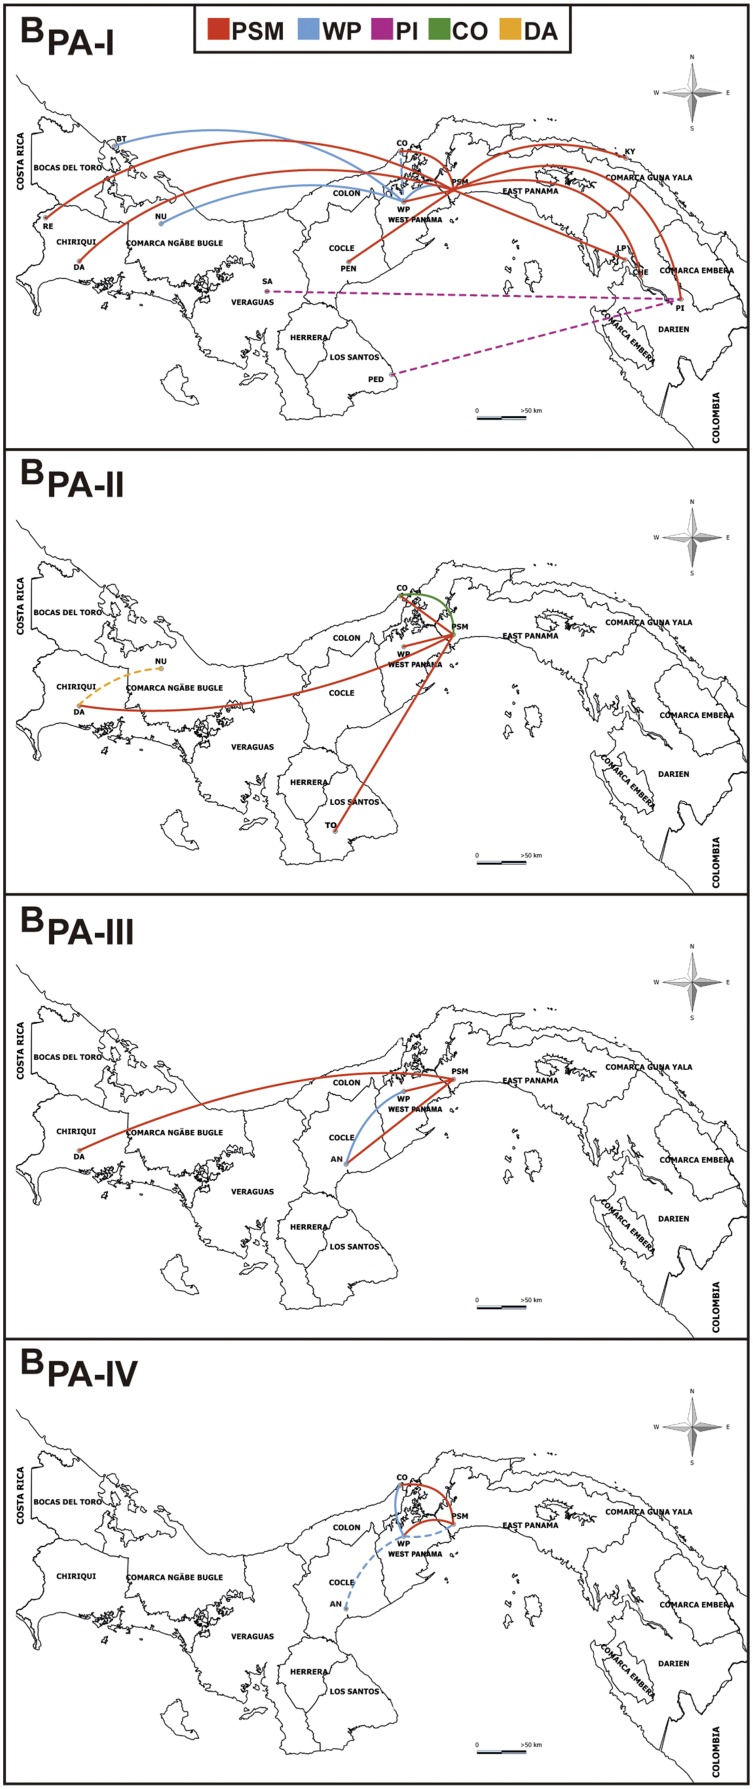
Spatial dissemination of HIV-1 Panamanian clades of large size (BPA-I to BPA-IV) across country districts.Lines between districts represent branches in the Bayesian MCC tree along which location transitions occur. Lines were colored according to the source location as indicated in the legend at top. Dashed lines indicate those location transitions associated to nodes with low location probability support (<0.60). AN, Anton; BT, Bocas del Toro; CHE, Chepigana; CO, Colon; DA, David; KY, Kuna Yala; MU, Muna; NU, Nurum; PED, Pedasí; PEN, Penonome; PI, Pinogana; PSM, Panama and San Miguelito (east Panama province); RE, Renacimiento; SA, Santiago; TO, Tonosí; WP, west Panama province.